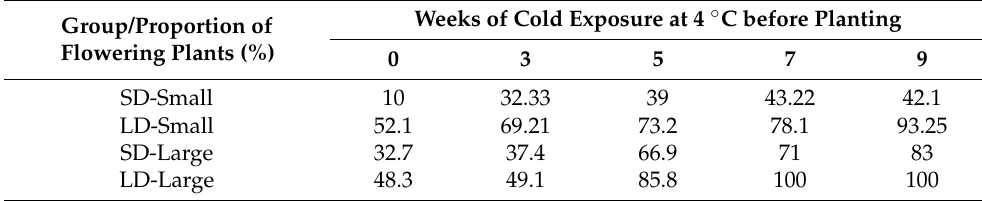
Table 1. Flowering rate of small and large bulbs grown under SD/LD conditions. Group/Proportion of Flowering Plants